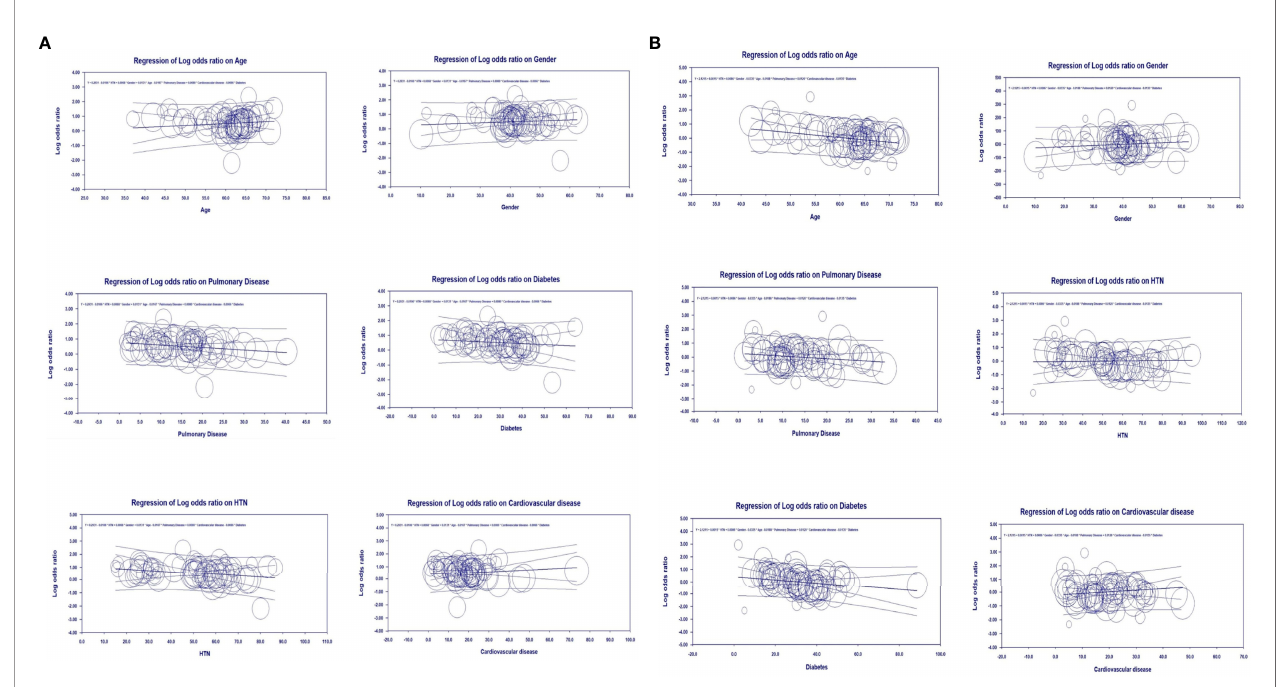
FIGURE 4 | Meta-regression analyses, (A) Severity meta-regression analysis, (B) Mortality meta-regression